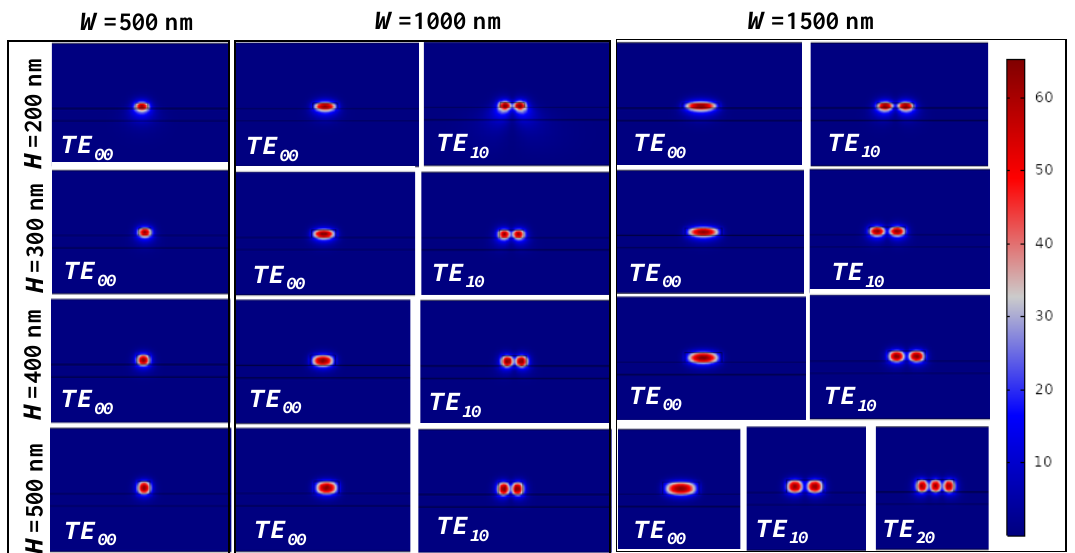
Figure 8. TE-mode distribution in ridge WG with different geometric parameters at an operational wavelength of 677 nm.